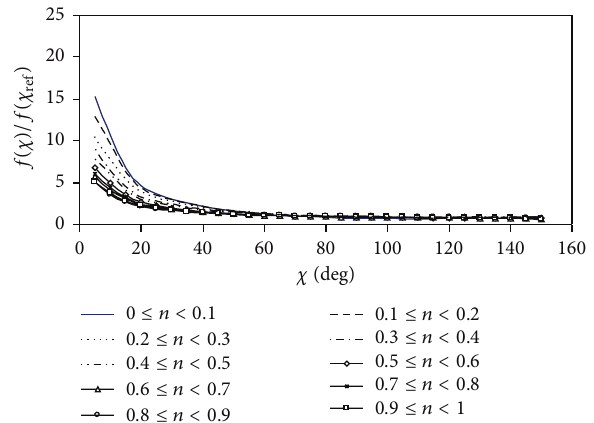
) versus 𝜒 for different values of cloud ref